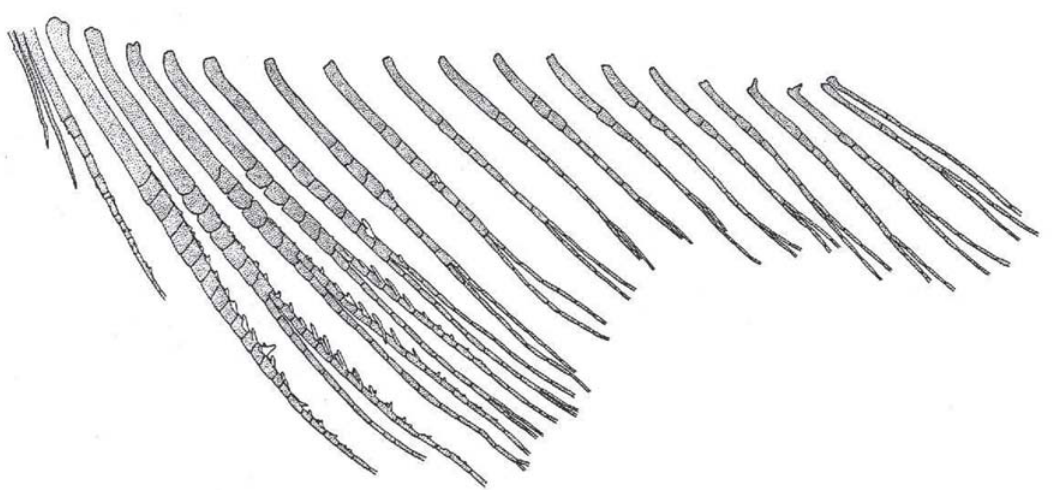
Fig. 26. Glandulocauda caerulea , adult male, USNM 326756, 39.4 mm SL; anal-fin rays, lateral view, left side. Lateral view, left side.